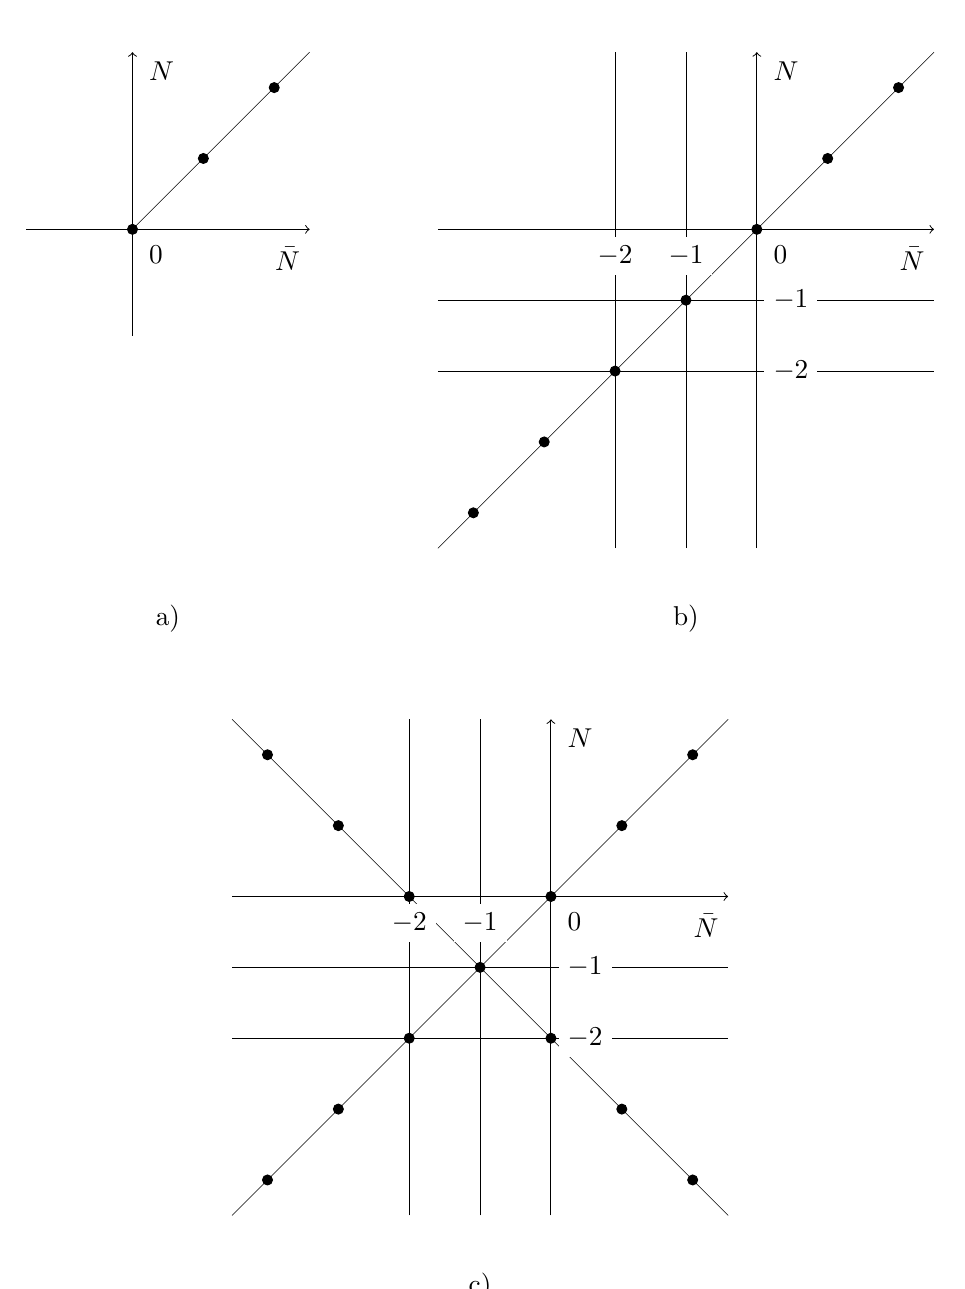
Figure 6 . Here we use the same conventions as for figure 5 to indicate non-vanishing F and G . On plot a) one has F = − 1 /R 2 for all F . On plot b) one has F ( − 2 , − 2) + F ( − 1 , − 1) = − 2 /R 2 , while all the remaining F are equal to − 1 /R 2 . Finally, for plot c) one has F ( − 2 , 2) + F ( − 1 , − 1)